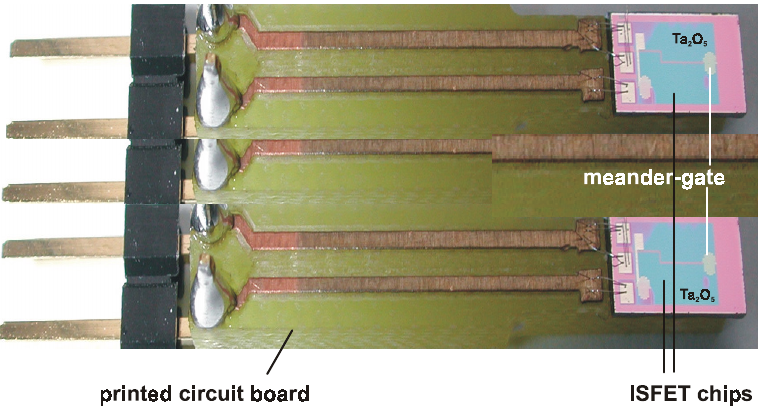
Figure 2. Photo of the ISFET module before